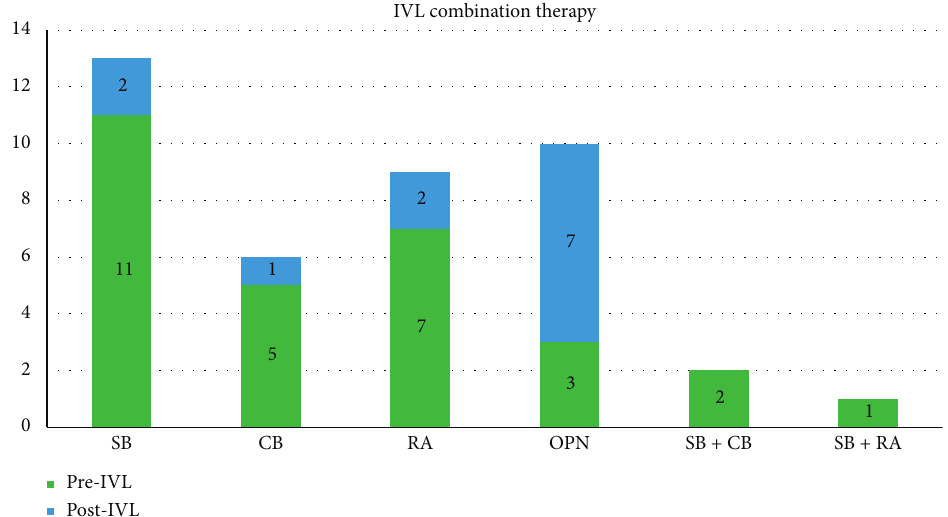
Figure 2: IVL use in combination therapy. SB � scoring balloon; CB � cutting balloon; OPN � high pressure balloon; RA � rotational atherectomy; IVL � intravascular